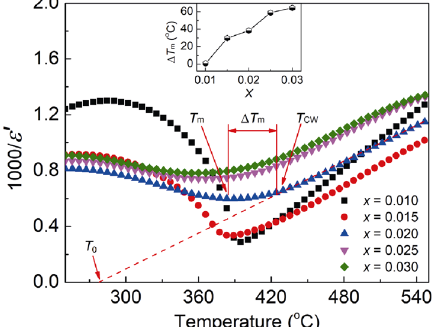
Fig. 5 Temperature dependence of reverse permittivity for (1 − x )KNN– x BZN ceramics with different BZN contents at 1 MHz. The inset shows deviation degree ( Δ T m ) as a function of BZN content ( x ).